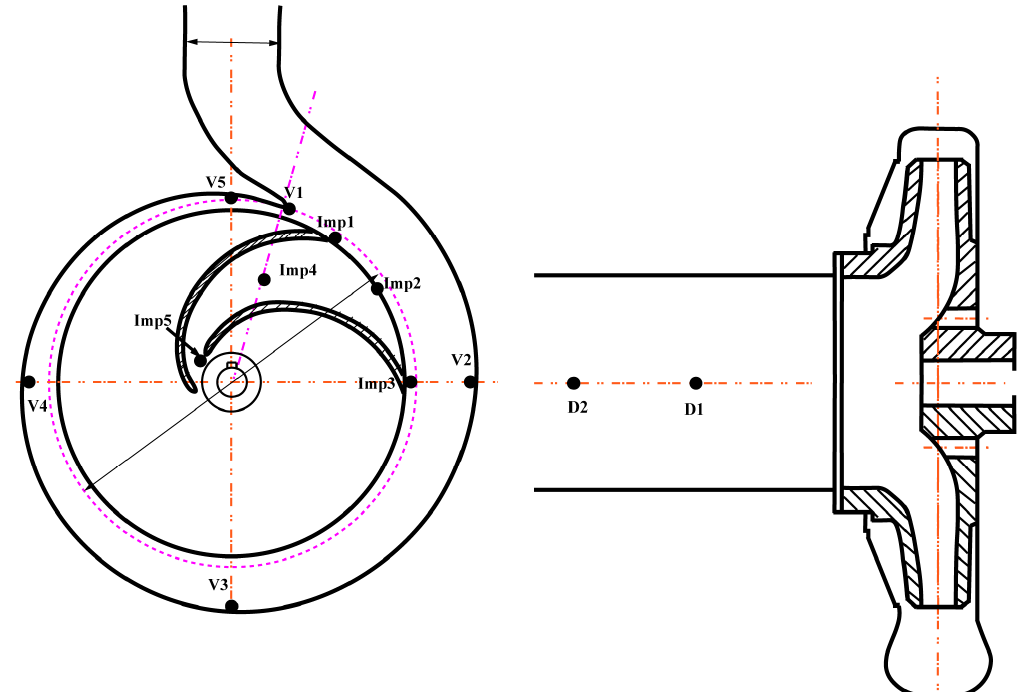
Figure 15. Monitoring points in the impeller, volute and outlet pipe channel.